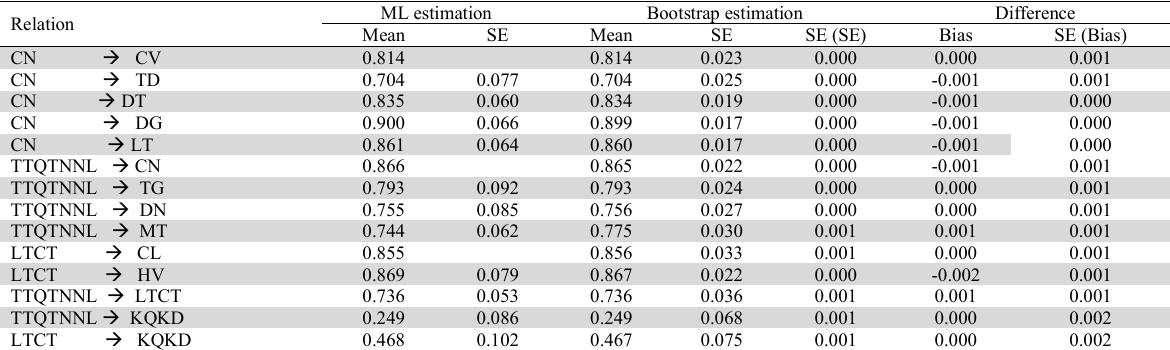
Bootstrap estimation vs. ML estimation results